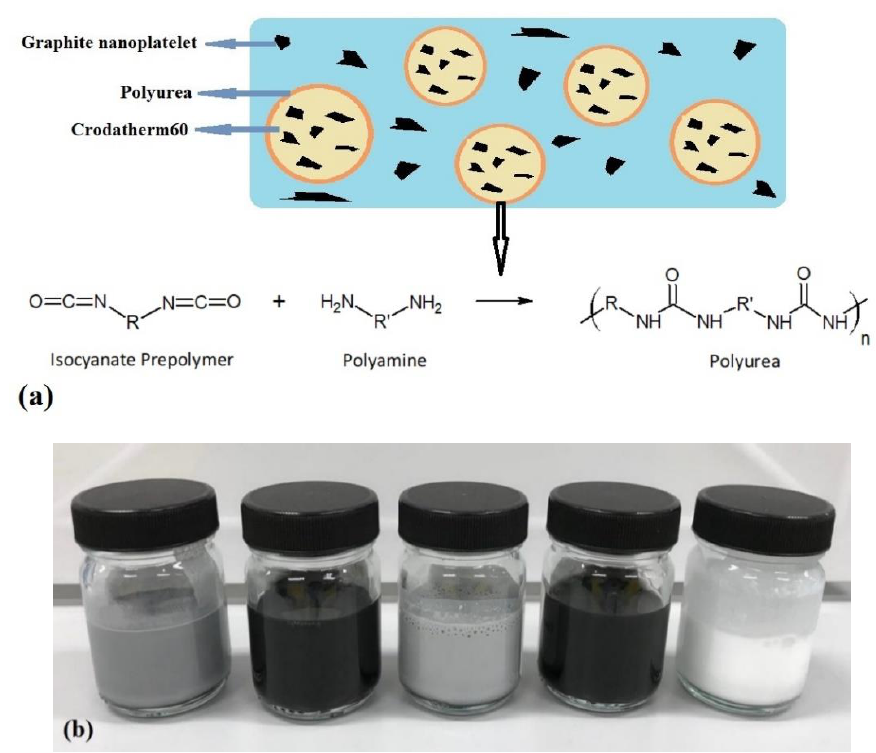
Figure 1. ( a ) Scheme of chemical interfacial reaction and structure of the prepared capsules; ( b ) from left to right Crodatherm60@polyurea-0.1%GNP, 0.1%GNP, Crodatherm60@polyurea-0.04%GNP,